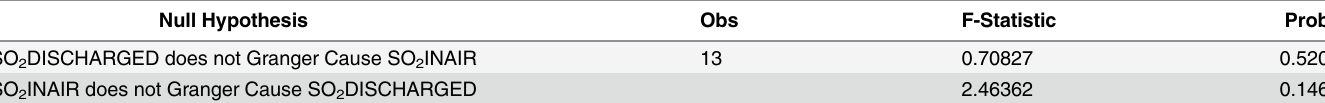
Table 1. Results of Granger